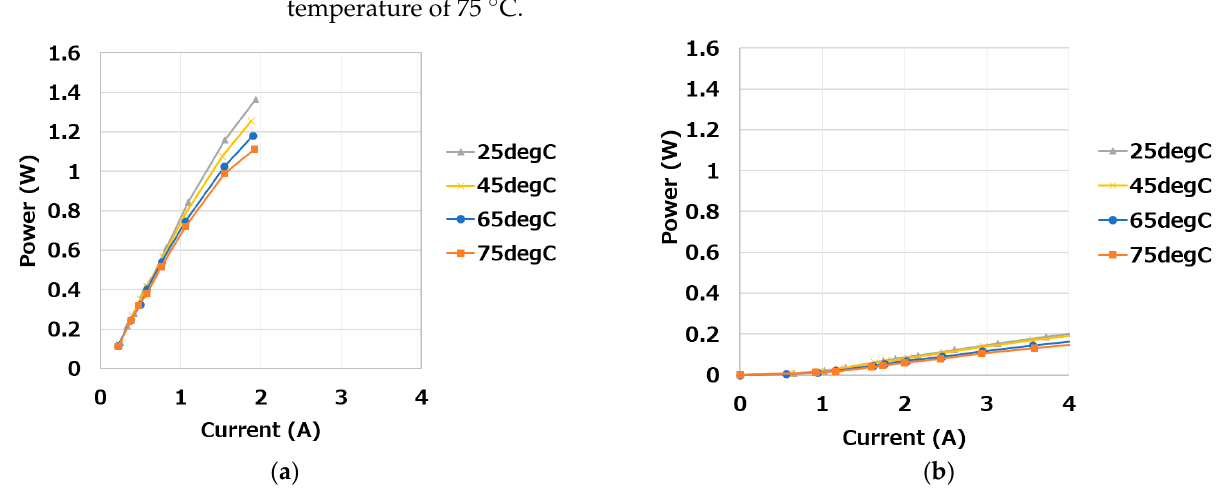
Figure 8. ( a ) I – L and ( b ) I – V characteristics of the SS-VCSEL during all-blocks emission at different temperatures.